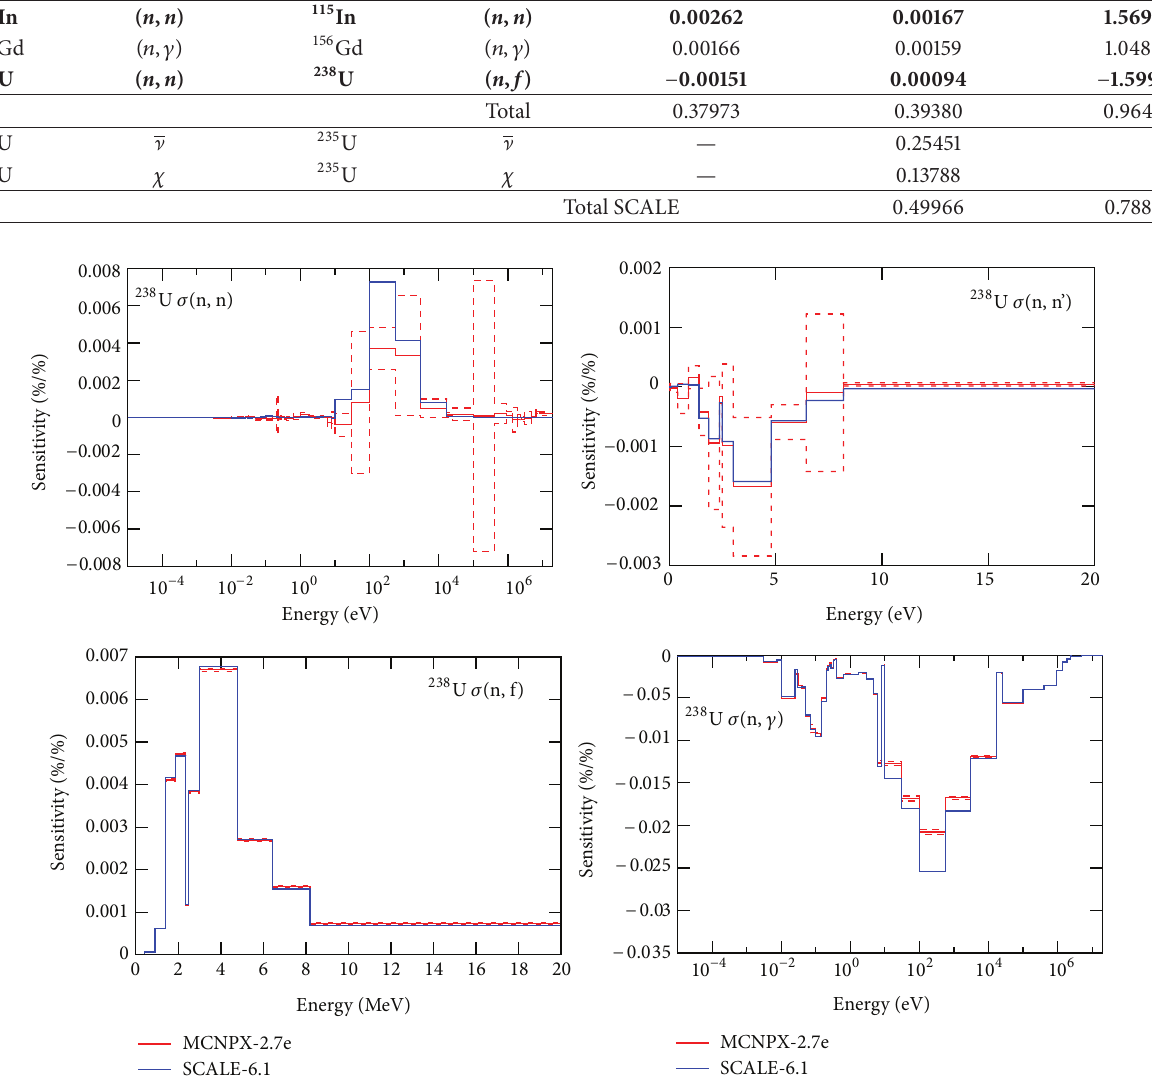
Figure 2: Sensitivity profiles of 238 U reaction cross sections calculated by MCNPX-2.7e and SCALE-6.1 for unrodded case at HZP.